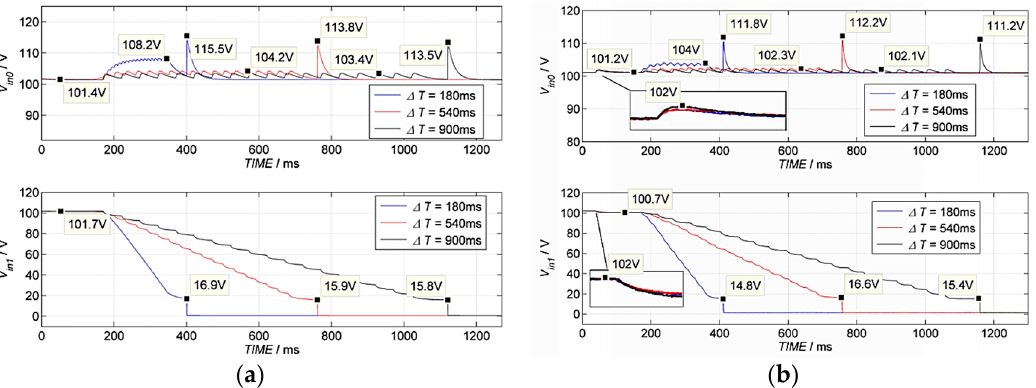
Figure 11. The ( a ) simulated and ( b ) experimental waveforms of the input voltages of module 0 and module 1 with ASB (2 modules).